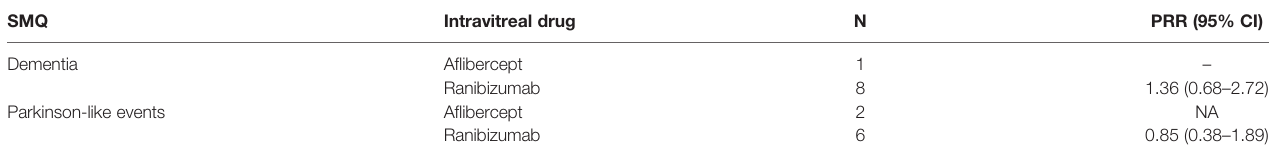
TABLE 3 | Individual case safety reports for intravitreal ranibizumab and a fl ibercept in persons aged 65 and over, grouped by standardized MedDRA ® query related to dementia and/or Parkinson-like events standardized MedDRA queries.